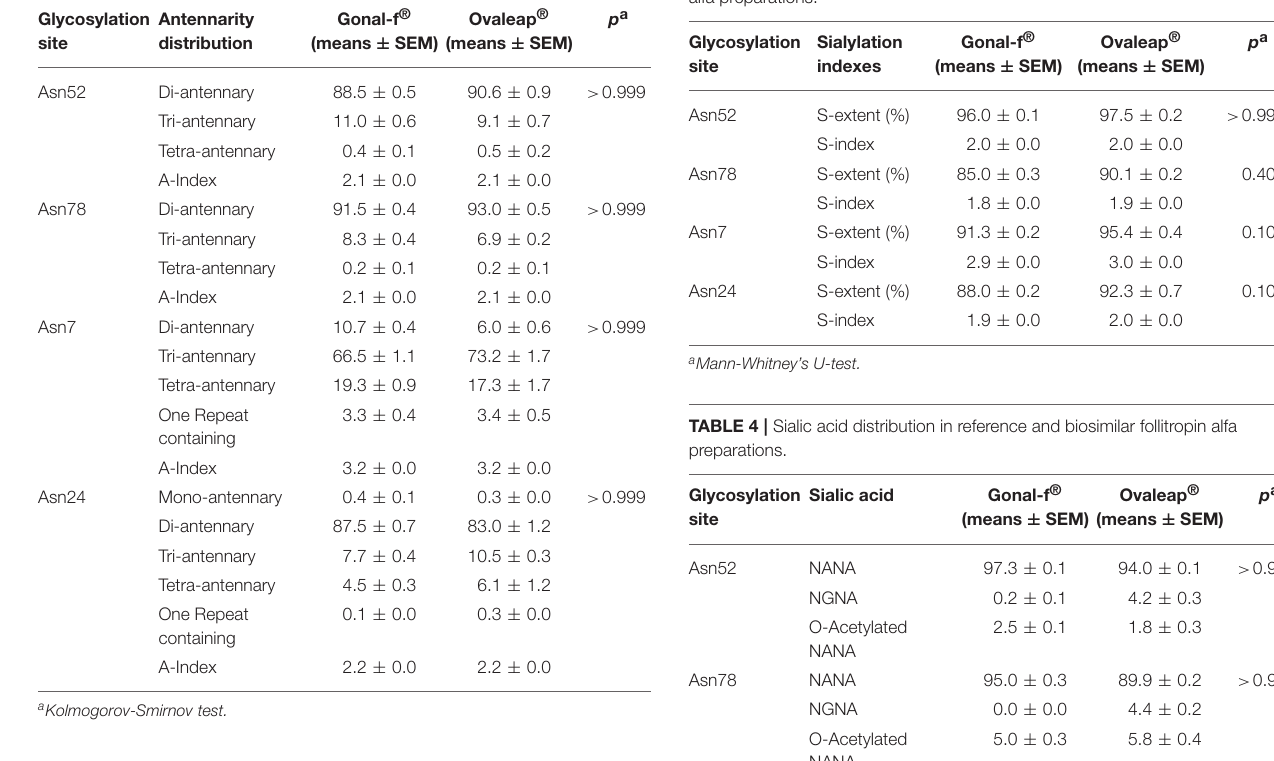
TABLE 2 | Antennarity of reference and biosimilar follitropin alfa preparations. TABLE 3 | Sialylation distribution in reference and biosimilar follitropin